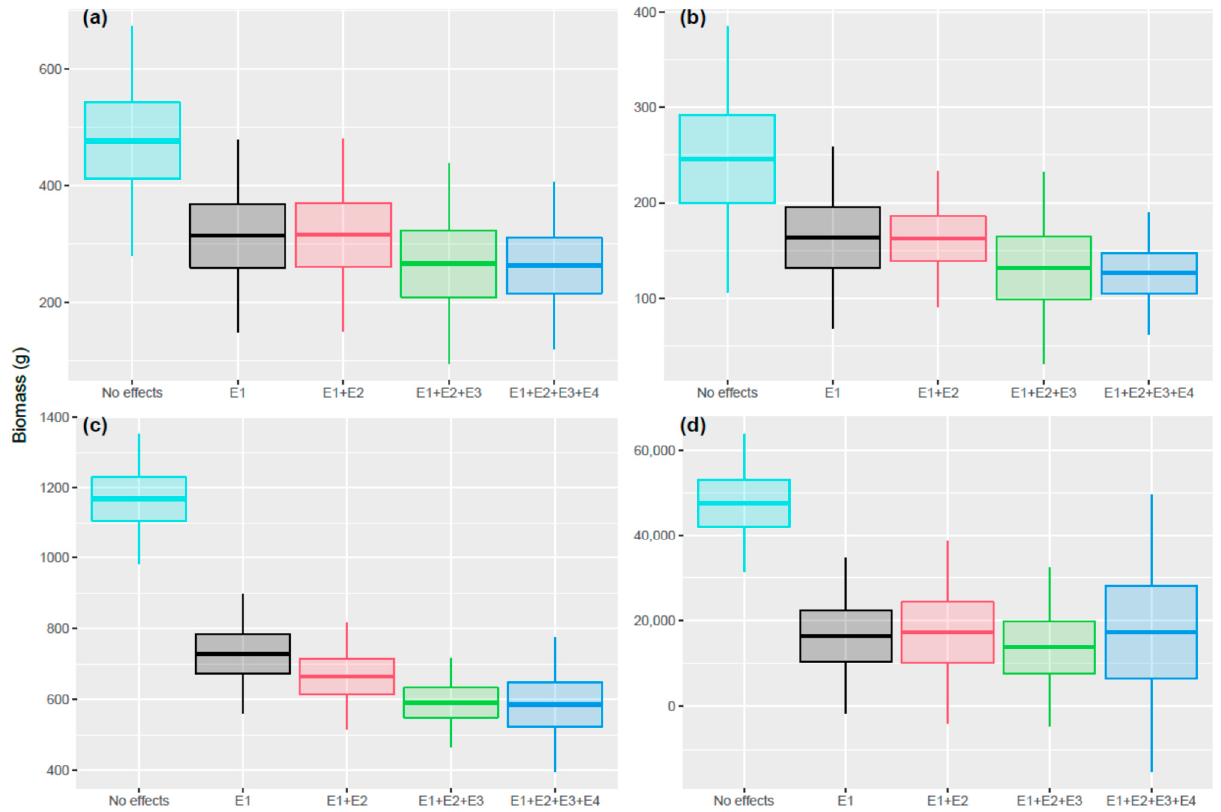
Figure 6. Average population biomasses for control simulations and when sequentially adding effect sub-models. Averages are calculated over exposure time (5 years) and over 40 replicates. The middle lines represent the mean biomass values, the boxes define the standard deviation, and the bars show three times the standard deviation. Different colors represent the tested effect scenarios. ( a ) Topeka shiner (EMF = 5); ( b ) Devils River minnow (EMF = 5); ( c ) Spikedace (EMF = 7); ( d ) Humpback chub (EMF =